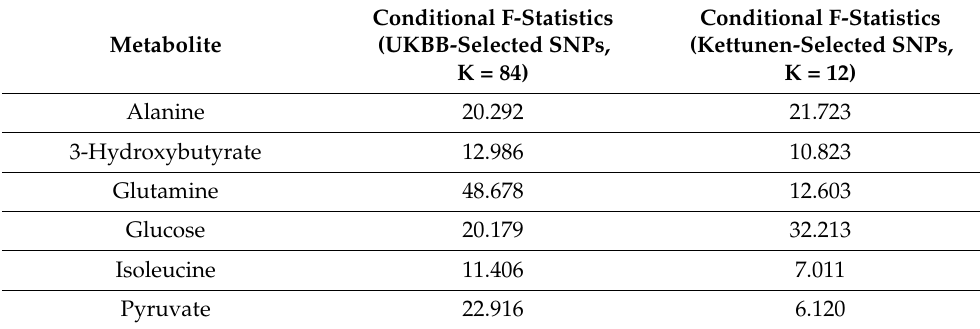
Table 1. The conditional F-statistics for the metabolic traits included in MVMR main analysis. Conditional F-Statistics Conditional F-Statistics (Kettunen-Selected Metabolite (UKBB-Selected SNPs, K = 84)